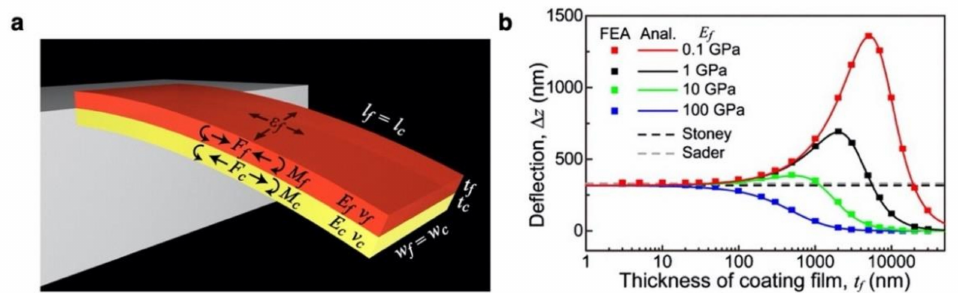
Figure 5. An analytical solution of cantilever-type nanomechanical sensor. ( a ) Schematic illustration of a cantilever coated with a film. ( b ) Dependence of a cantilever deflection on the thickness of coating films t f with various Young’s moduli of coating films E f ranging from 0.1 to 100 GPa calculated by Equation (9). The values calculated by FEA are represented with solid squares. Black and gray dashed lines correspond to the cantilever deflection calculated by the Stoney’s equation in Equation (3) and Sader’s model in Equation (4) with Equation (8), respectively. l f = l s = 500 [ µ m]; w f = w s = 100 [ µ m]; t s = 1 [ µ m]; E s = 170 [GPa]; ν s = 0.28; ν f = 0.30; and σ surf = 0.1 [N m − 1 ]. Reprinted with permission from Ref. [80]. Copyrights 2012, American Institute of